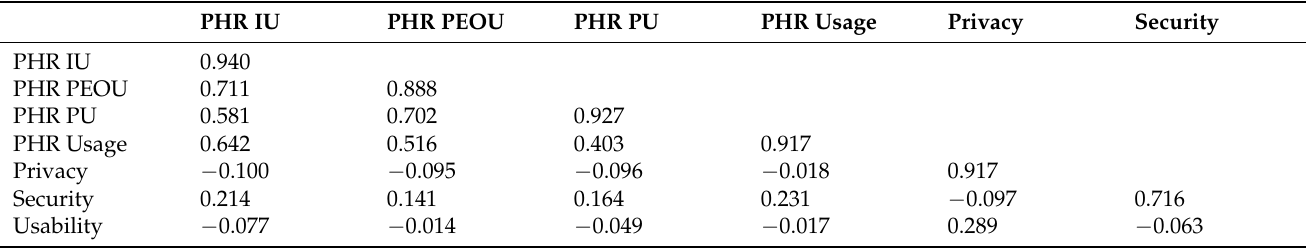
Table 3. Construct Discriminant Validity.